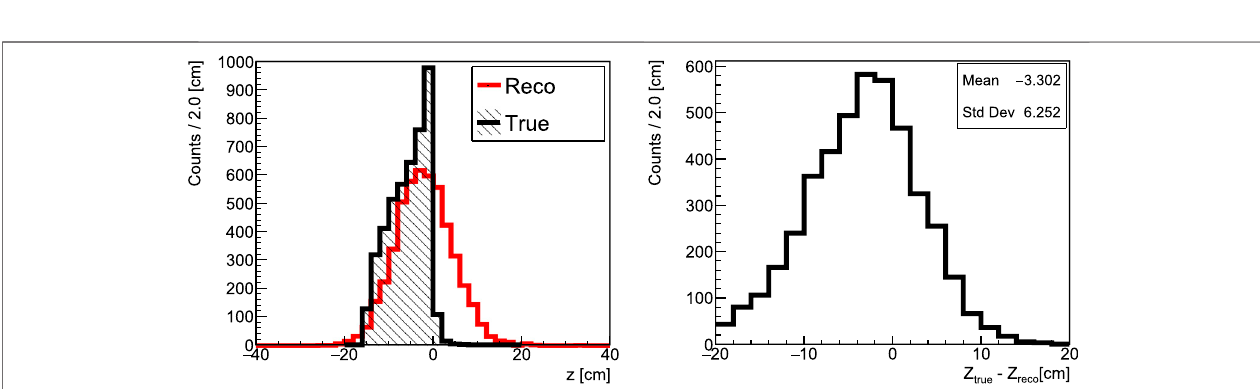
FIGURE 10 | Left: reconstructed prompt photons emission distribution along the beam axis (z coordinate) (red line; white area) obtained from 10 11 160 MeV protons impinging on a PMMA target. The distribution of the actual points at production is superimposed (black line; black area). Right: the difference between the z coordinateofthephotonatgeneration( Z true )andofthereconstructedphoton( Z reco ),obtainedfrom10 11 160 MeVprotonsimpingingonaPMMAtarget.A ∼ − 3 cmbias on the mean value of the distribution is visible.